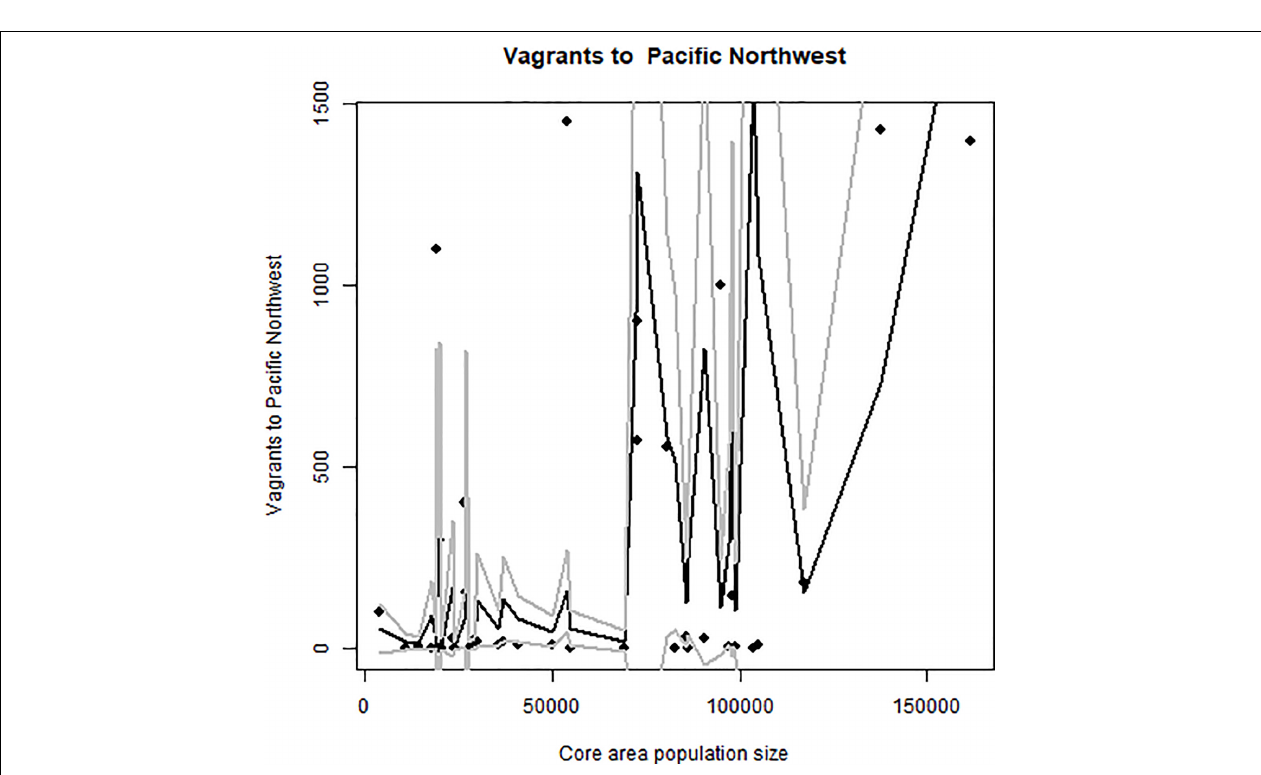
Frontiers in Ecology and Evolution |